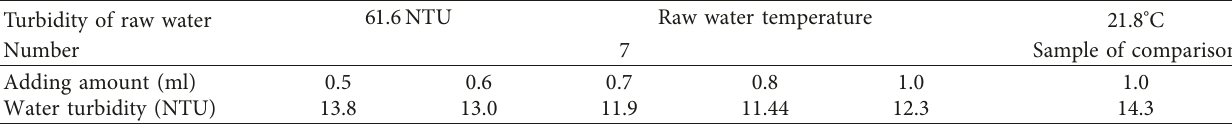
Table 9: Formula no. 7 treatment of tap water source water-related case.